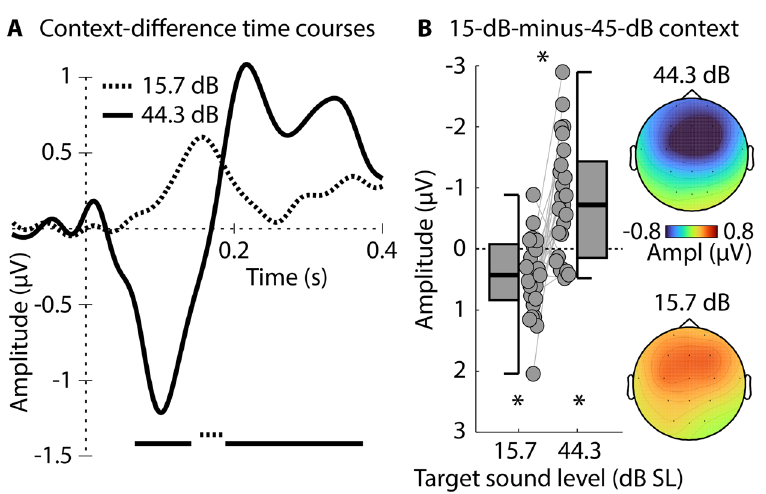
Figure 5. Response difference between the two statistical contexts (15-dB mode minus 45-dB mode). ( A ) Difference time courses for the two target-intensity categories (15.7 dB, 44.3 dB). The lines at the bottom reflect a significant difference from zero (FDR-corrected 68,69 ). ( B ) Amplitude difference between the 15-dB SL and 45-dB SL contexts, separately for low- and high-intensity targets (time windows 0.1-0.2 s and 0.05–0.15 s, respectively). Note that negative amplitude differences are plotted upwards, in order to facilitate correspondence with Figs. 1, 4, and 7. The reversed polarity relative to the other figures is the result of the negative potential, possibly reflecting a prediction-error signal. Topographical distributions reflect the mean response difference between the two statistical contexts. * p ≤